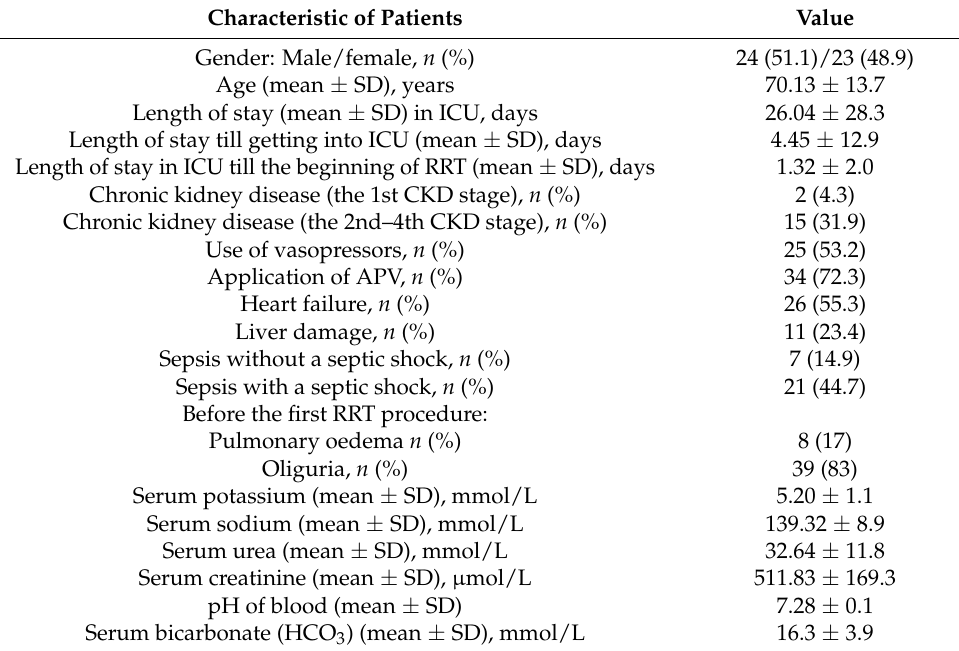
70.13 ± 13.7 26.04 ± 28.3